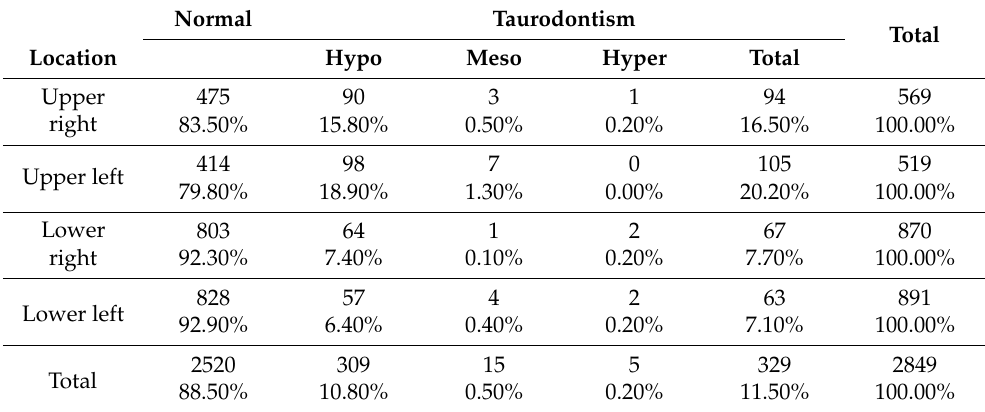
Table 2. The distribution of taurodontism in right and left